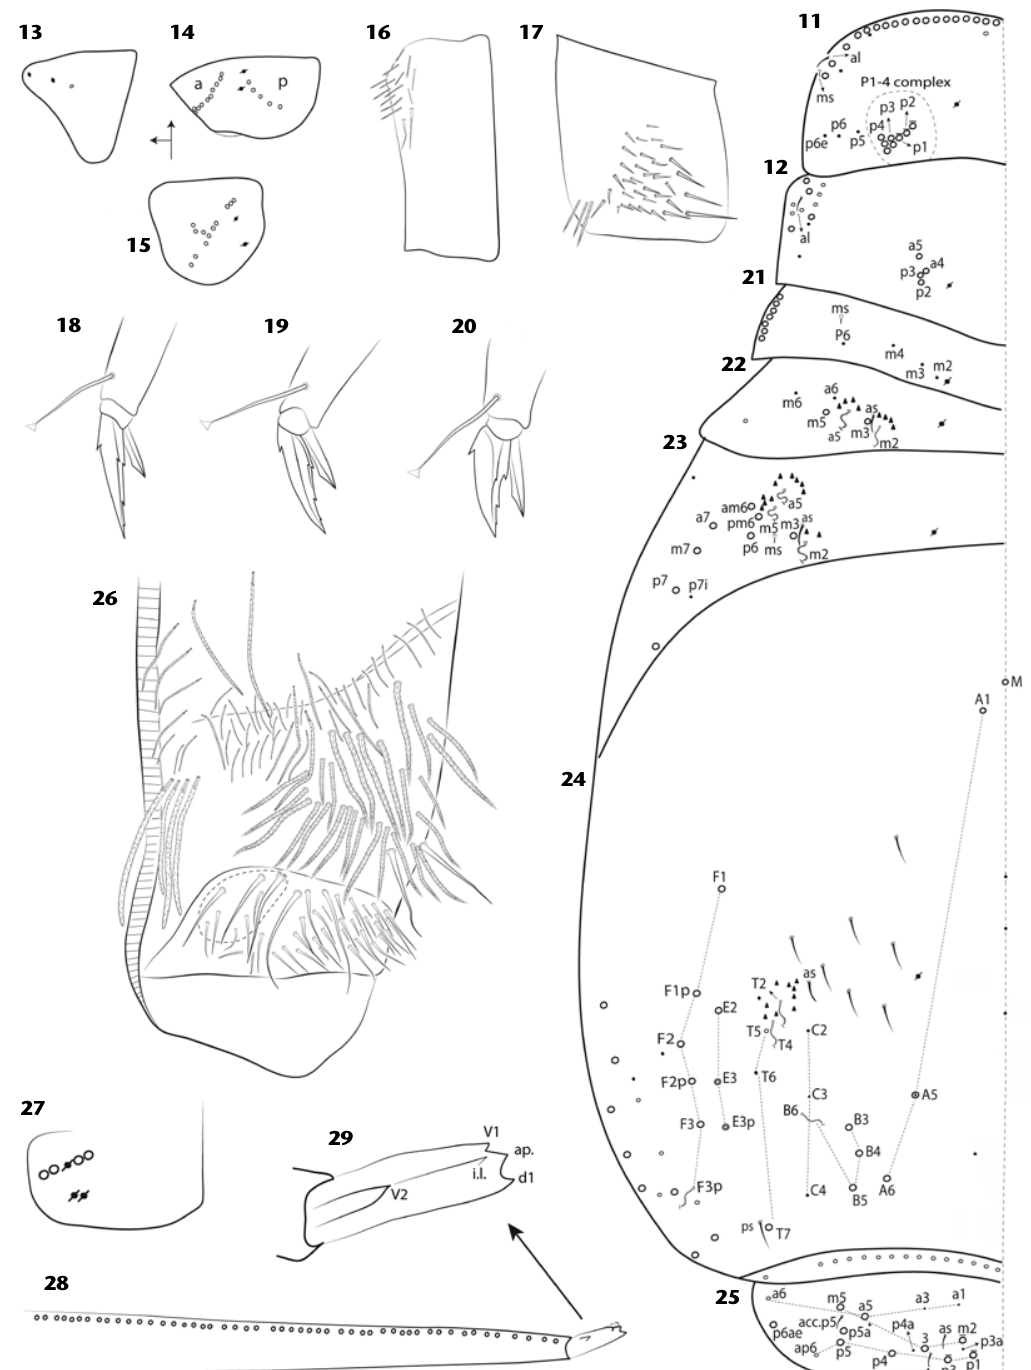
6Figures 11-29. Campylothorax viruaensis sp. nov. : (11) mesothorax dorsal chaetotaxy; (12) metathorax dorsal chaetotaxy; (13) subcoxa I; (14) subcoxa II; (15) subcoxa III; (16) trochanter I; (17) trochanteral organ; (18) foot I complex; (19) foot II complex; (20) foot III com- plex; (21) abdomen I dorsal chaetotaxy; (22) abdomen II dorsal chaetotaxy; (23) Abdomen III dorsal chaetotaxy; (24) abdomen IV dorsal chaetotaxy; (25) abdomen V dorsal chaetotaxy; (26) collophore; (27) manubrial plate; (28) dental spines; (29)